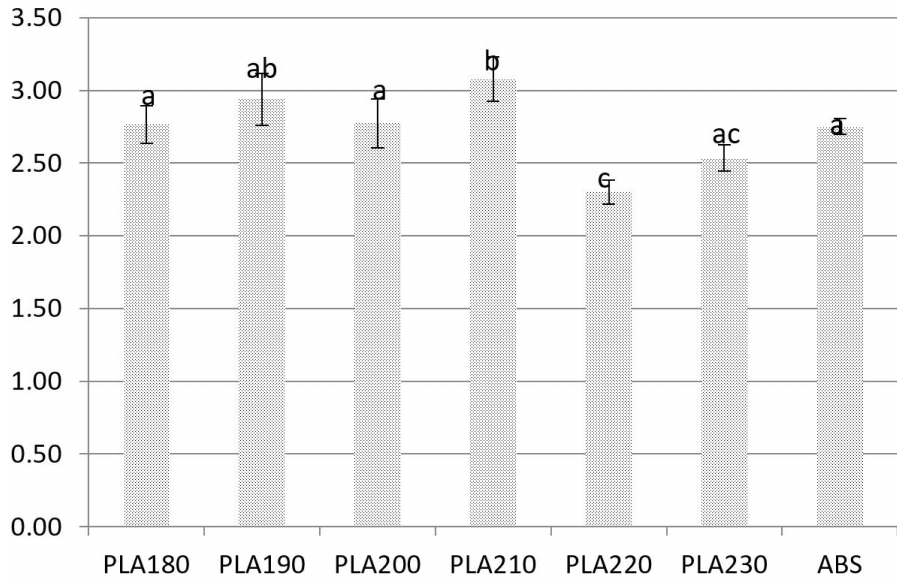
Figure 4. Young’s modulus values measured by US. Bars with the different letters (a, b, c) are significantly different.